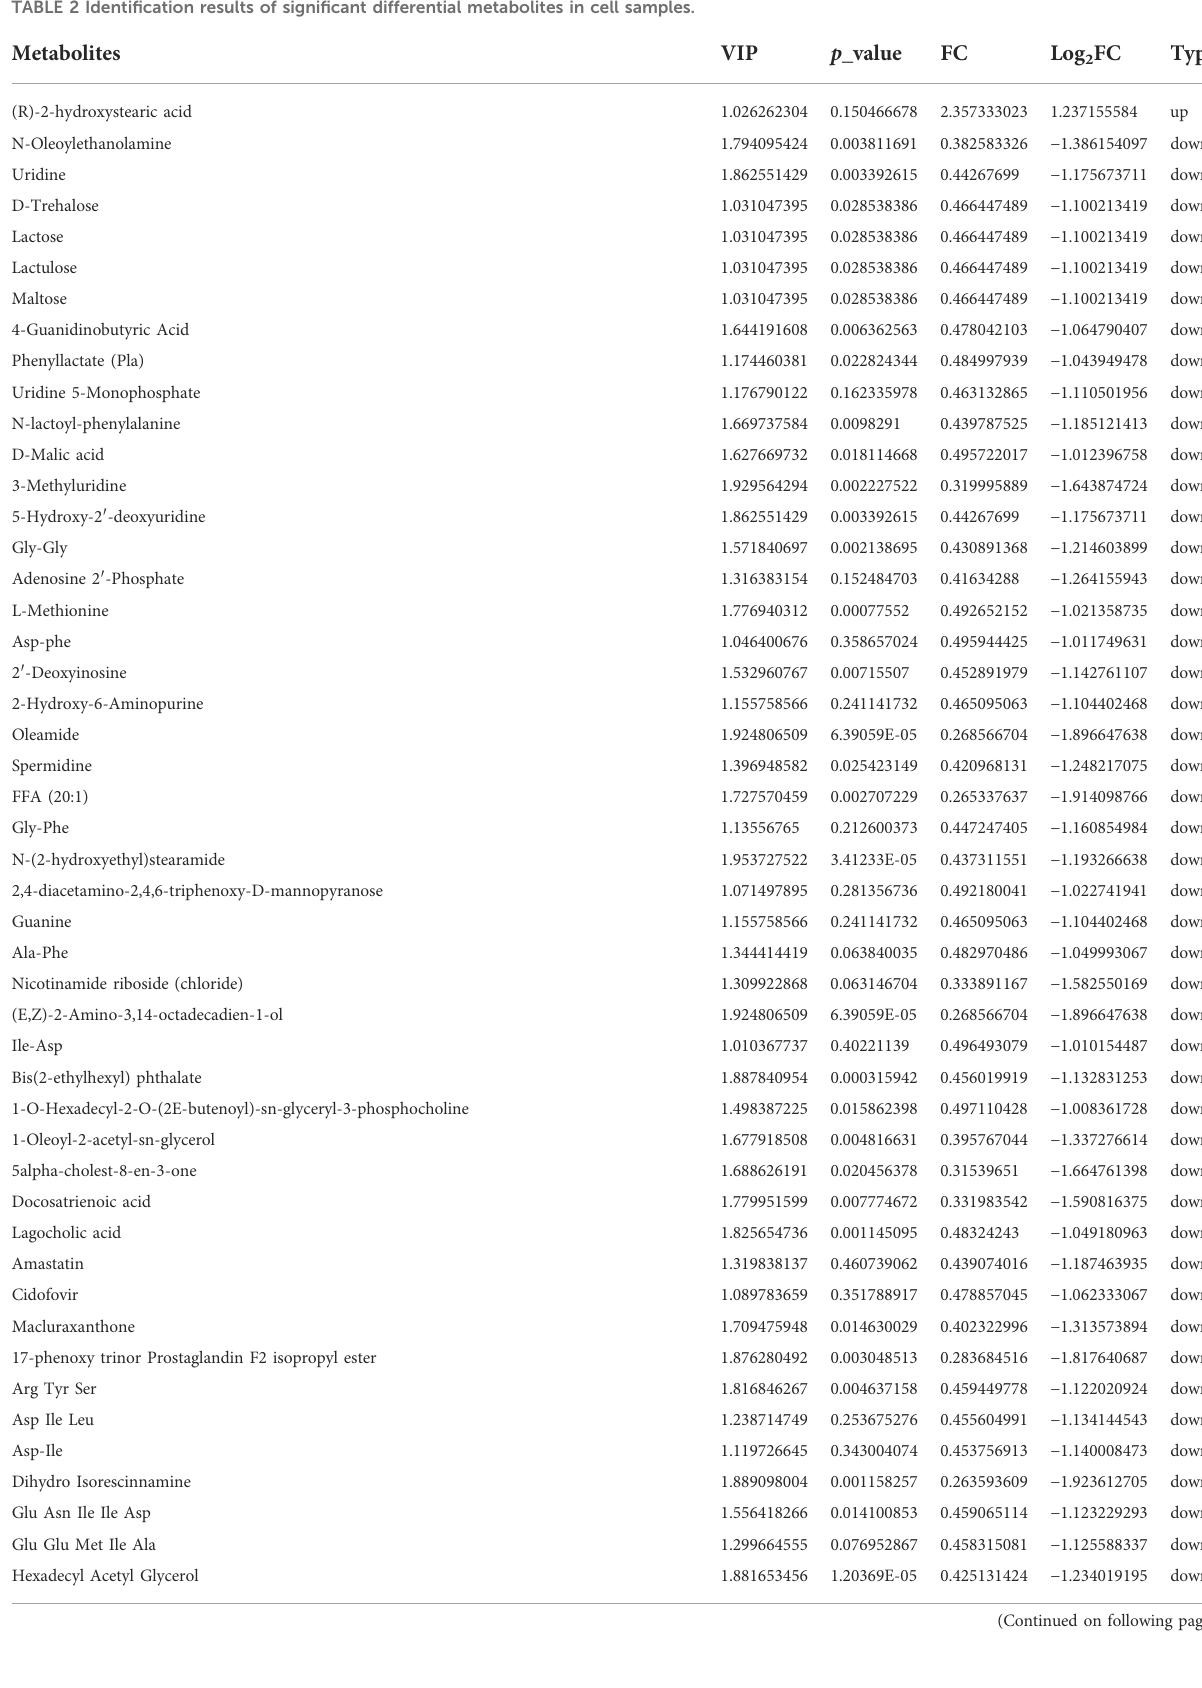
TABLE 2 Identi fi cation results of signi fi cant differential metabolites in cell